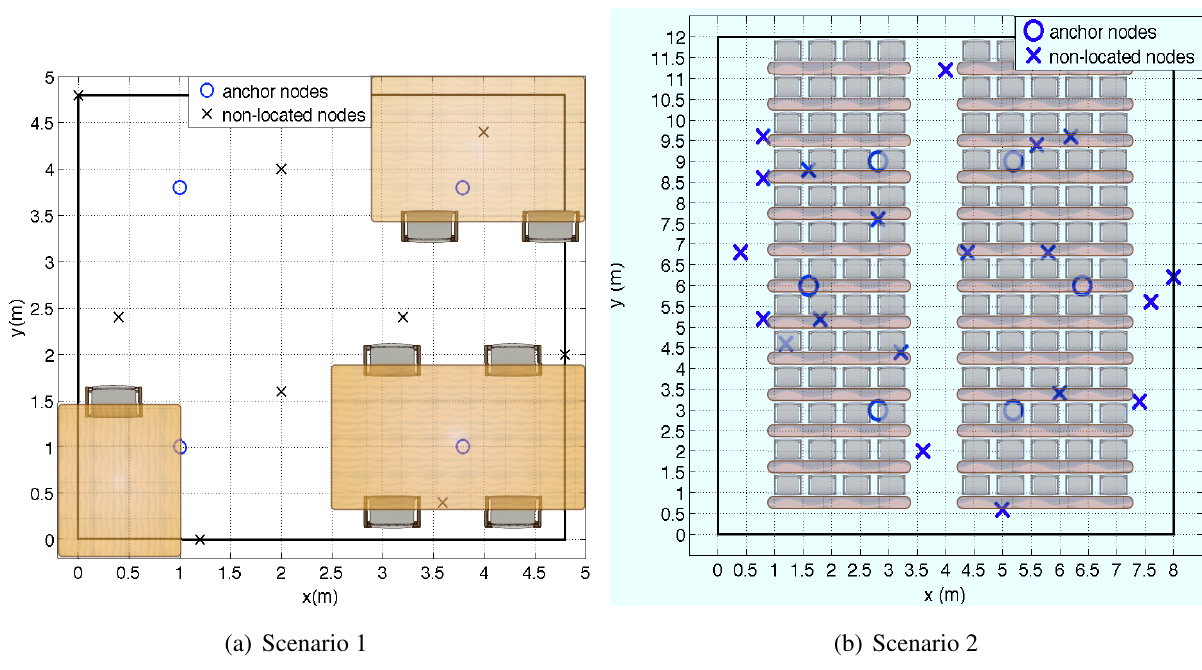
Figure 10. Experimental